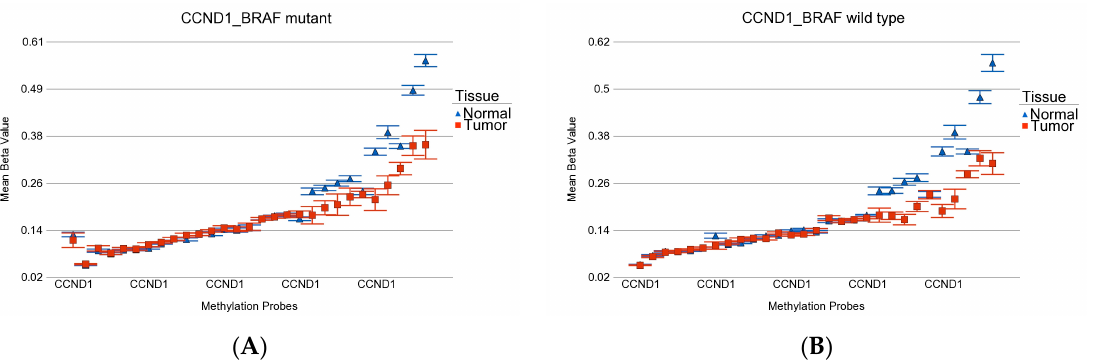
Figure 6. Differential methylation status of all the probes for CCND1 promoter. Differential methylation in BRAF mutant patients is shown in ( A ), and the differential methylation in BRAF wild-type patients is shown in ( B ). Gene probes are arranged on the x -axis by methylation level, and the mean of the beta value is shown on the y -axis. Multiple probes show similar hypomethylation in both BRAF mutant and wild-type tumors.